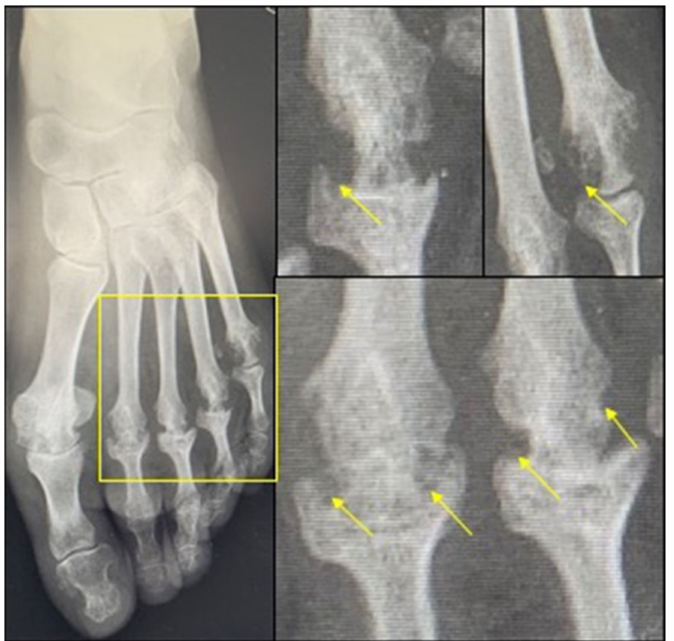
Figure 1. Bone erosions of the foot in rheumatoid arthritis (RA). Arrows show erosions on metacar- pophalangeal